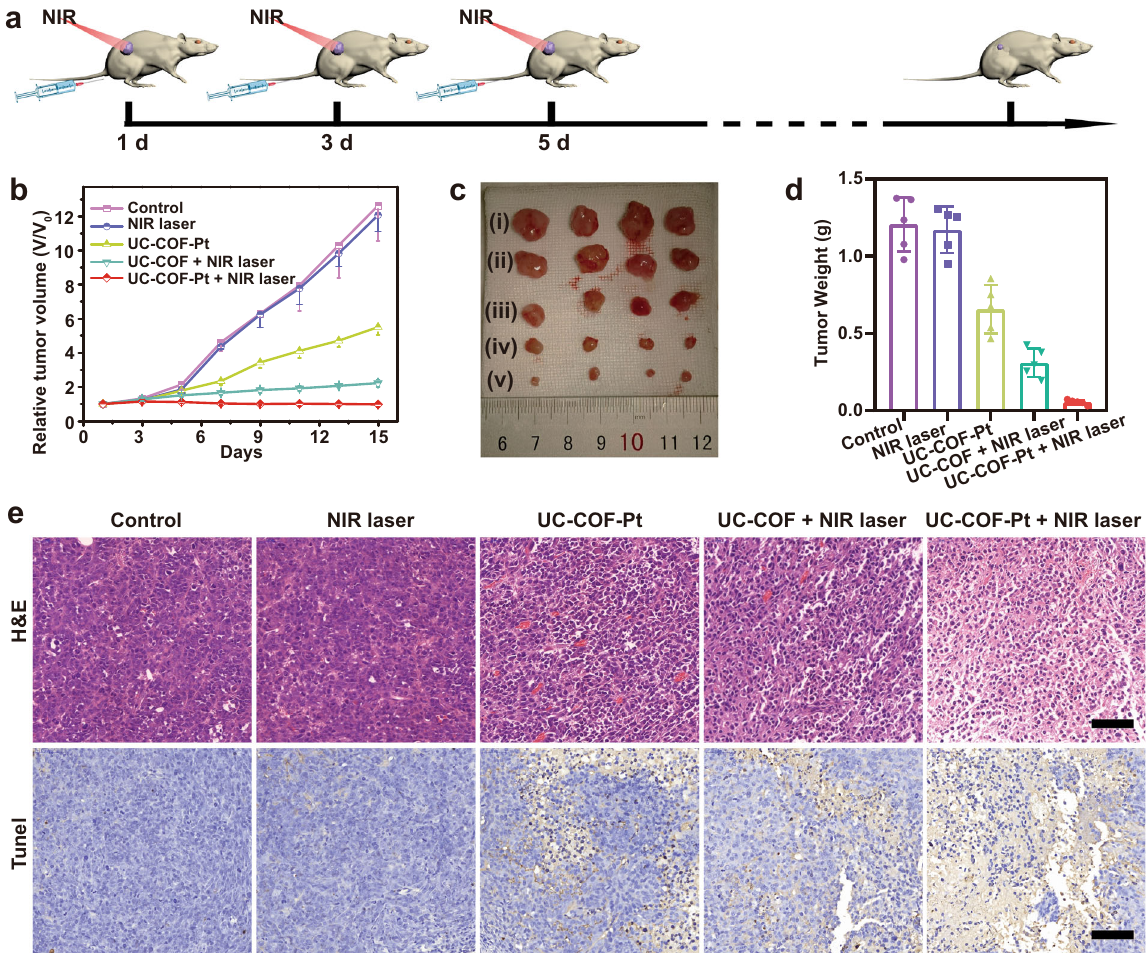
Fig. 5 In vivo antitumor ef fi ciency of UC-COF on 4T1-tumor-bearing mice. a Schematic illustration of the building of subcutaneous tumor model and NIR light-triggered combinational therapy. b Tumor volume change of experimented mice under different treatments. c Photographs (i: Control, ii: NIR laser, iii: UC-COF-Pt, iv: UC-COF + laser, and v: UC-COF-Pt + laser), ( d ) weight, and ( e ) immunohistochemical analysis of extracted tumors from different groups after treatments. Scale bars in ( e ) are 200 μ m. Data in ( b ) and ( d ) are presented as mean ± s.d. derived from n = 5 independent biological mice. Source data underlying ( b ) and ( d ) are provided as a Source Data fi